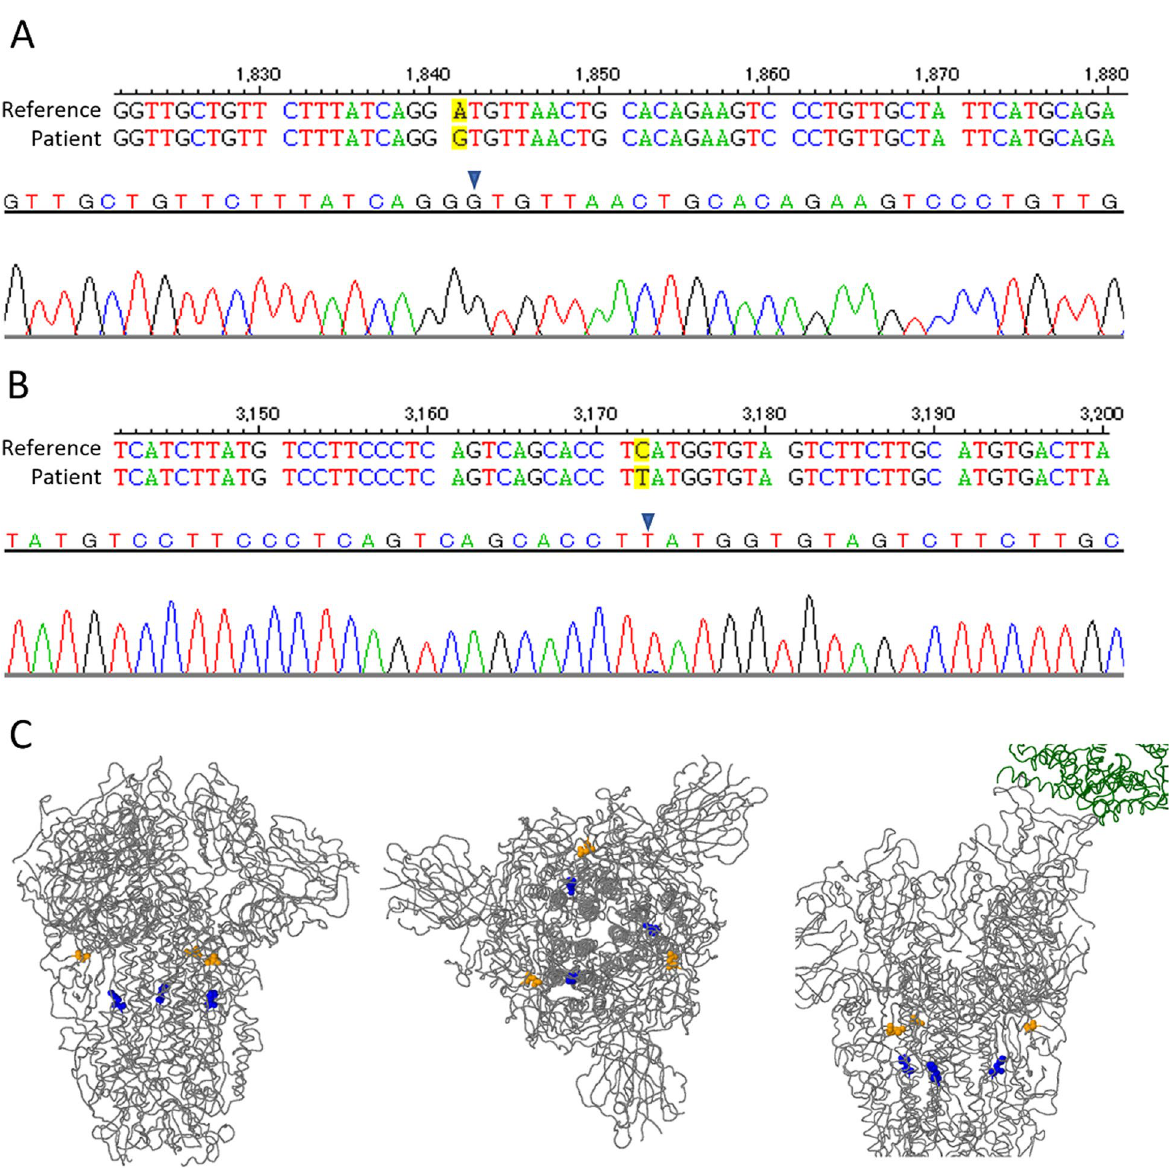
Fig. 3 Sequencing and identification of mutations in the viral S gene. Comparisons of the reference sequence of the S gene and the sequence obtained from the patient’s oropharyngeal and nasopharyngeal swab are shown, at the sites where the two mutations were found. A The change of an adenine for a guanine at position 1841 (A1841G) is highlighted in yellow, and the electropherogram obtained where this mutation was found (black arrow) is shown. B The change of a cytosine for a thymine in position 3172 (C3172T) and the electropherogram where this mutation was found. C Three‑dimensional structural visualization of the viral S protein with the amino acid changes identified, shown as colored balls: mutation D614G in yellow and mutation H1058Y in blue. Lateral view (left), upper (center) and lateral view bound to the ACE‑2 receptor (in green,